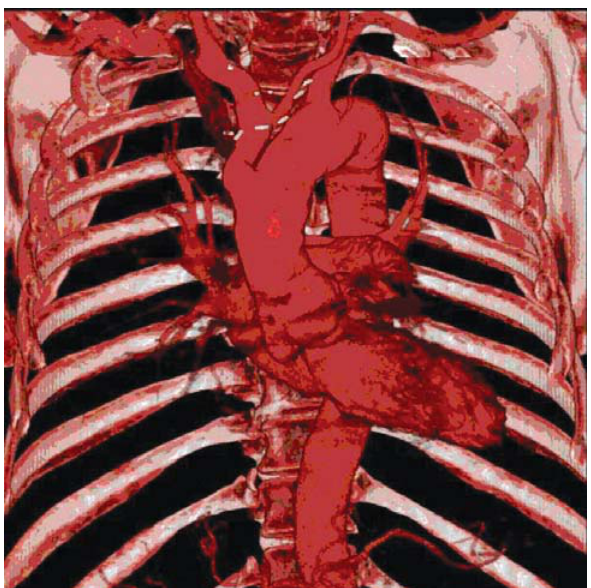
Fig. 4 - Estudo angiotomográfico de 1 ano de pós-operatório de paciente tratado com a técnica